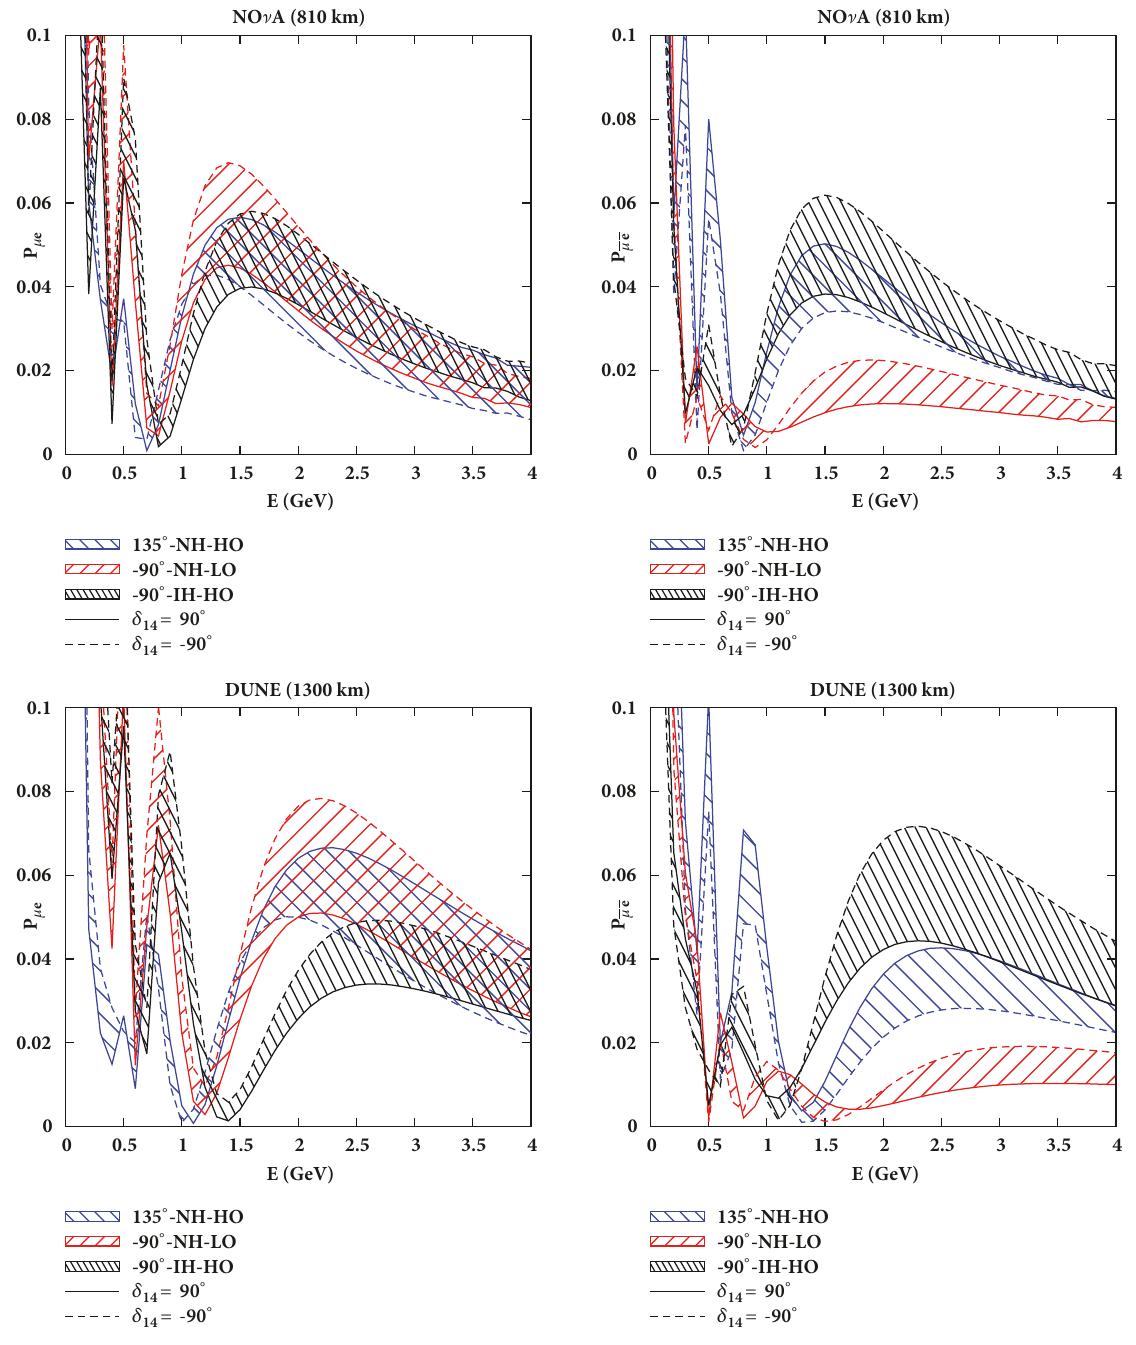
Figure 1: The oscillation probability P 𝜇𝑒 as a function of energy. The top (bottom) panel is NO ] A (DUNE). The bands correspond to different values of 𝛿 14 , ranging from -180 ∘ to 180 ∘ when 𝛿 24 = 0 ∘ . Inside each band, the probability for 𝛿 14 = 90 ∘ ( 𝛿 14 = -90 ∘ ) case is shown as the solid (dashed) line. The left (right) panel corresponds to neutrinos (antineutrinos).